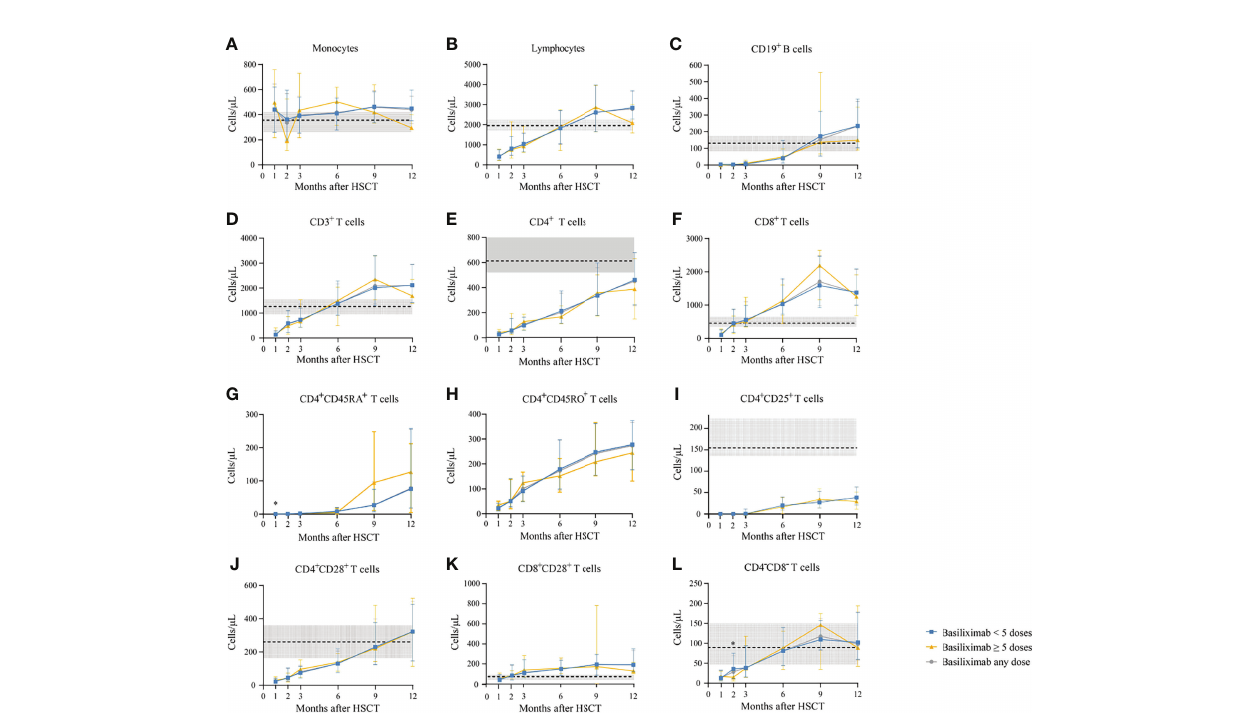
FIGURE 3 | (A-L) Kinetics of immune reconstitution in grade II SR-aGVHD patients who showed an ORR after basiliximab treatment. Because of lack of data about CD4 + CD45RA + T cells and CD4 + CD45RO + T cells in healthy donors, the values of these two immune cell subsets in healthy donors are not shown. Data are shown as median absolute counts with error bars indicating the 25th – 75th percentiles. The horizontal dotted lines represent the median value of healthy cohorts, and the gray areas represent the 25th – 75th percentiles for the healthy cohorts. * P < 0.05, basiliximab <5 doses vs. basiliximab ≥ 5 doses. ORR, overall response rate; SR- aGVHD, steroid-refractory acute graft-versus-host